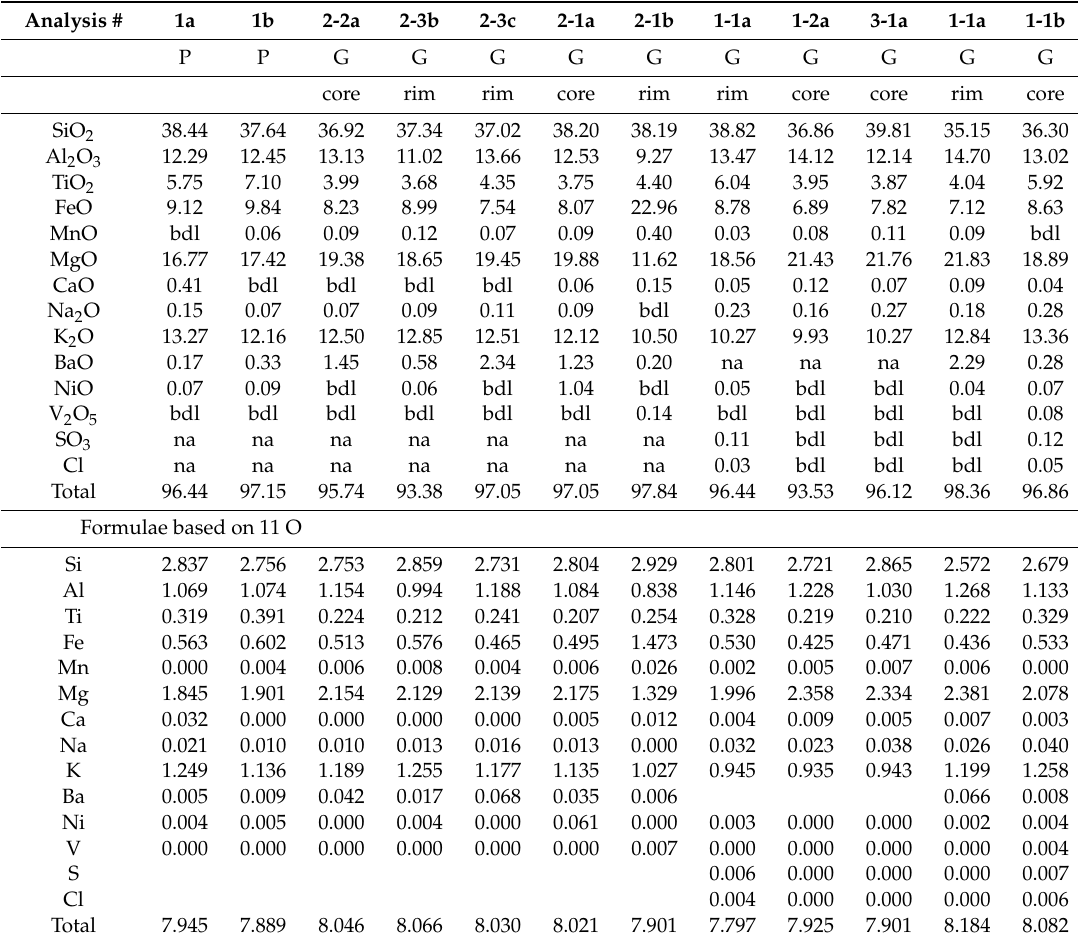
Table 2. Representative chemical compositions (wt.%) and mineral formulae (apfu) of mica from the Vinoren